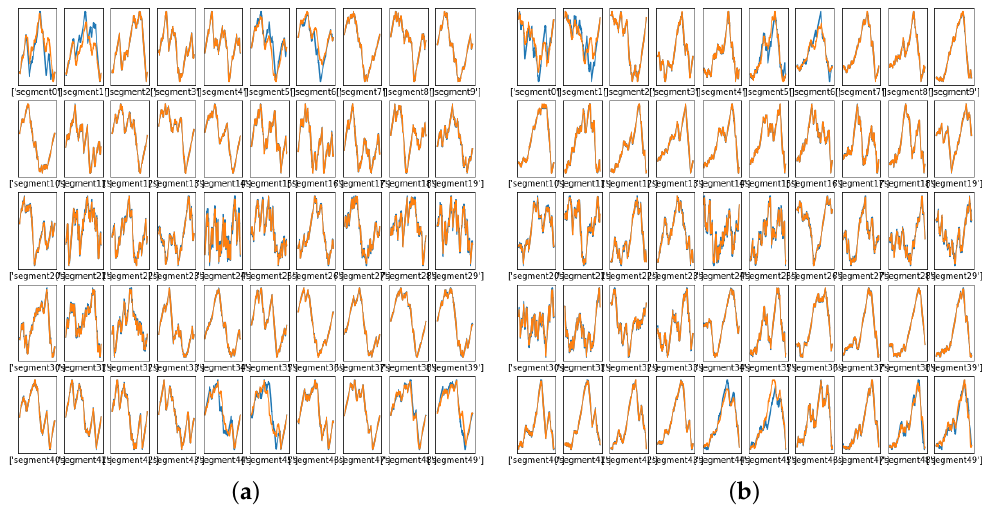
Figure 15. Learned warping paths a and b , Phase Three. ( a ) Warping path a , 5000 iterations. ( b ) Warping path b , 5000 iterations.